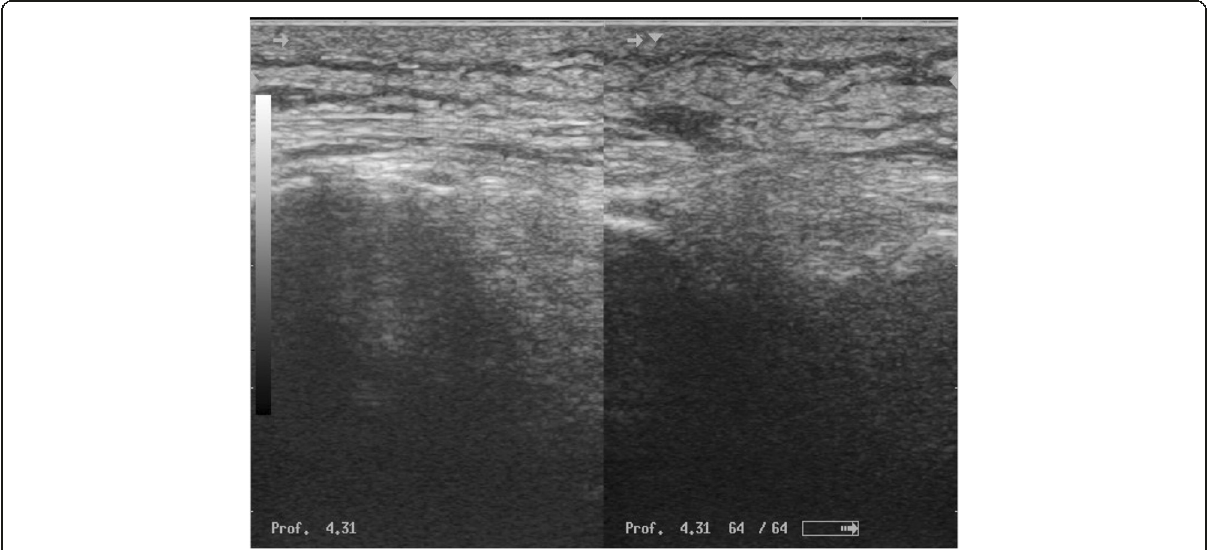
Fig. 2 Ultrasound image of the soft parts of the leg. Thickening of the soft tissue with an echogenic laminated appearance